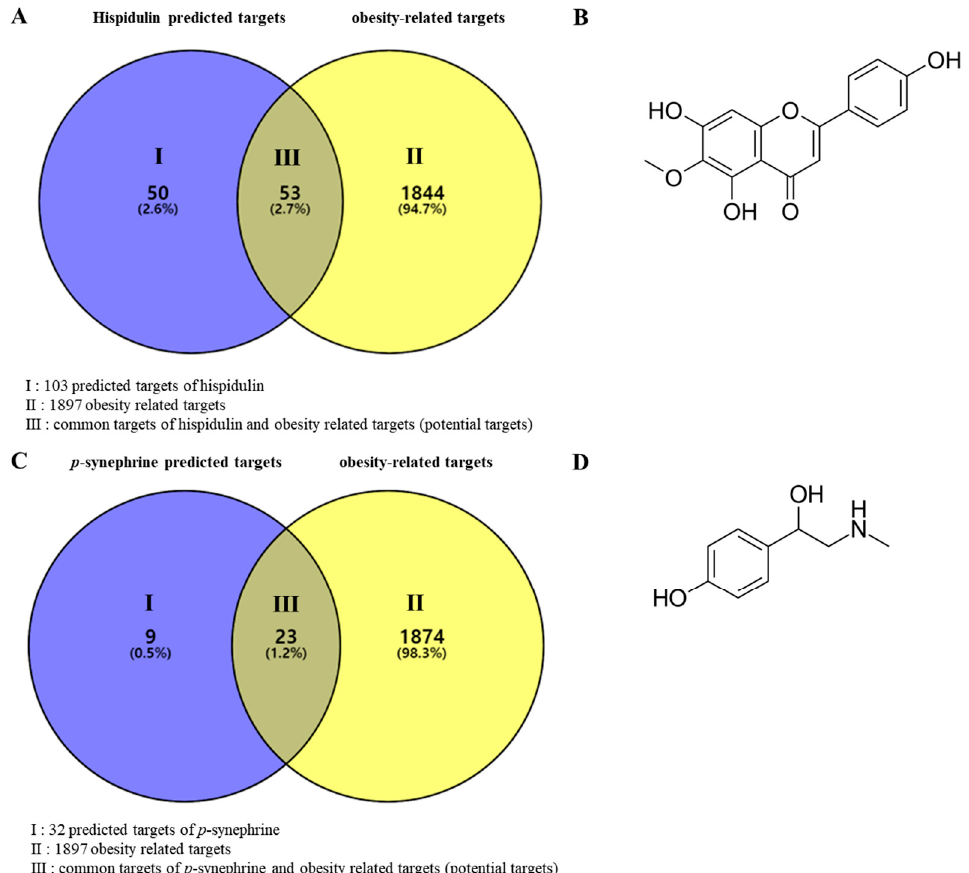
Figure 1. Venn diagrams of predicted targets of compounds and obesity-related targets. ( A ) Venn diagram of hispidulin-predicted targets and obesity-related targets. ( B ) Chemical structure of hispidulin. ( C ) Venn diagram of p -synephrine-predicted targets and obesity-related targets. ( D ) Chemical structure of p -synephrine.